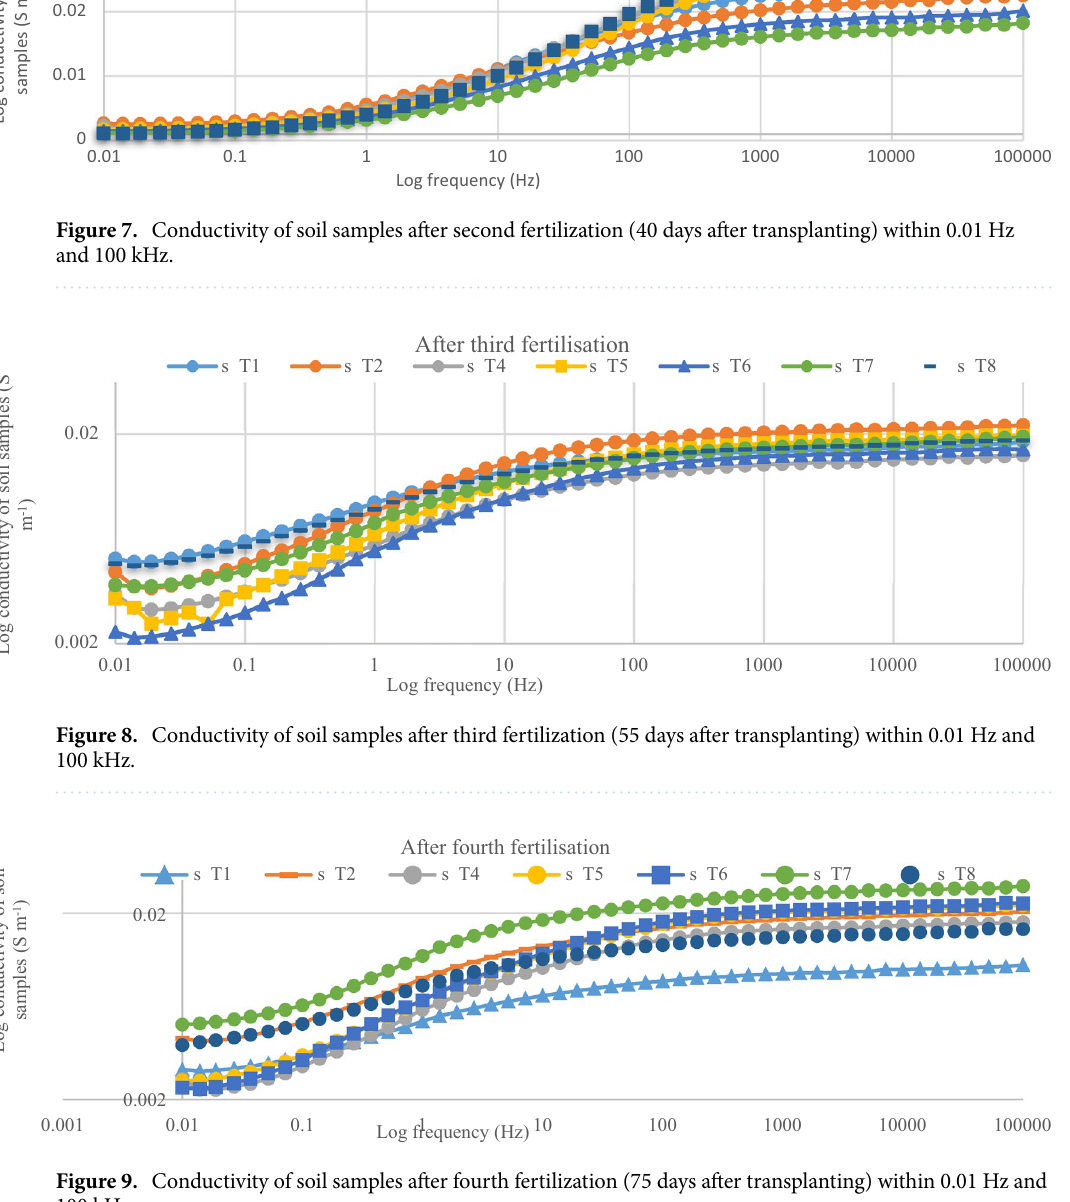
Figure 9. Conductivity of soil samples after fourth fertilization (75 days after transplanting) within 0.01 Hz and 100